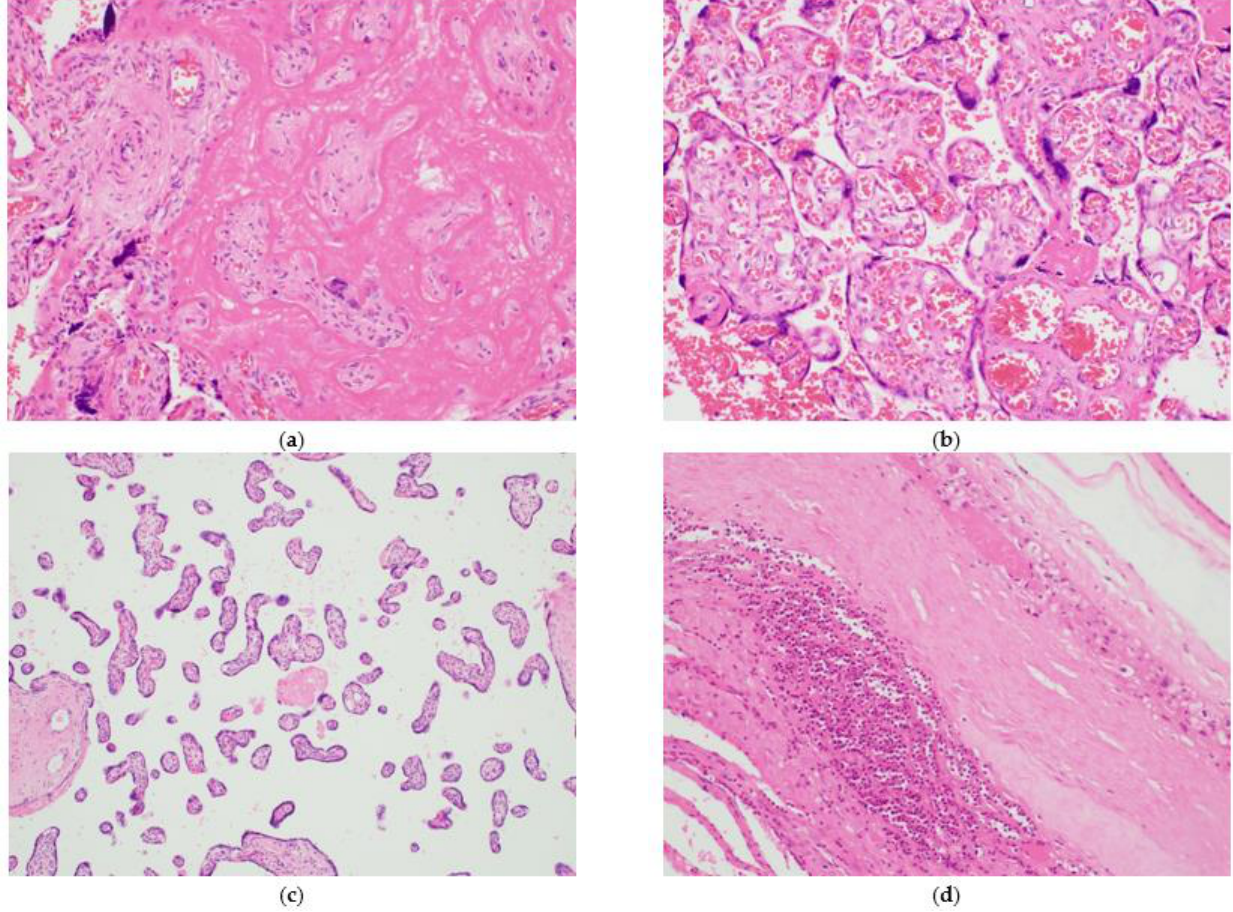
Figure 1. Pathologic features of placentas: ( a ) fibrin deposition in patient 7: the section is characterized by the extensive deposition of fibrinoid material in the intervillous space (200×); ( b ) chorangiosis in patient 4: chorionic villi showing an increased number of capillaries with a dilated lumen (200×); ( c ) distal villous hypoplasia in patients 2 and 7: the section reveals long, elongated, and edematous villi with reduced numbers of syncytial knots (100×); ( d ) chorioamnionitis in patients 1 and 7: neutrophilic infiltrate of chorion was present and amnion as intact (200×).